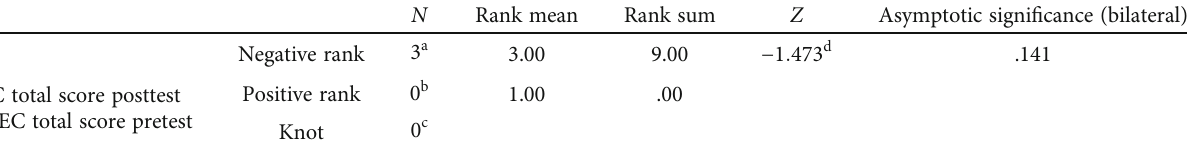
Table 2: Signed-rank sum test results of ATEC total score of children in control group. N ATEC total score posttest — ATEC total score pretest